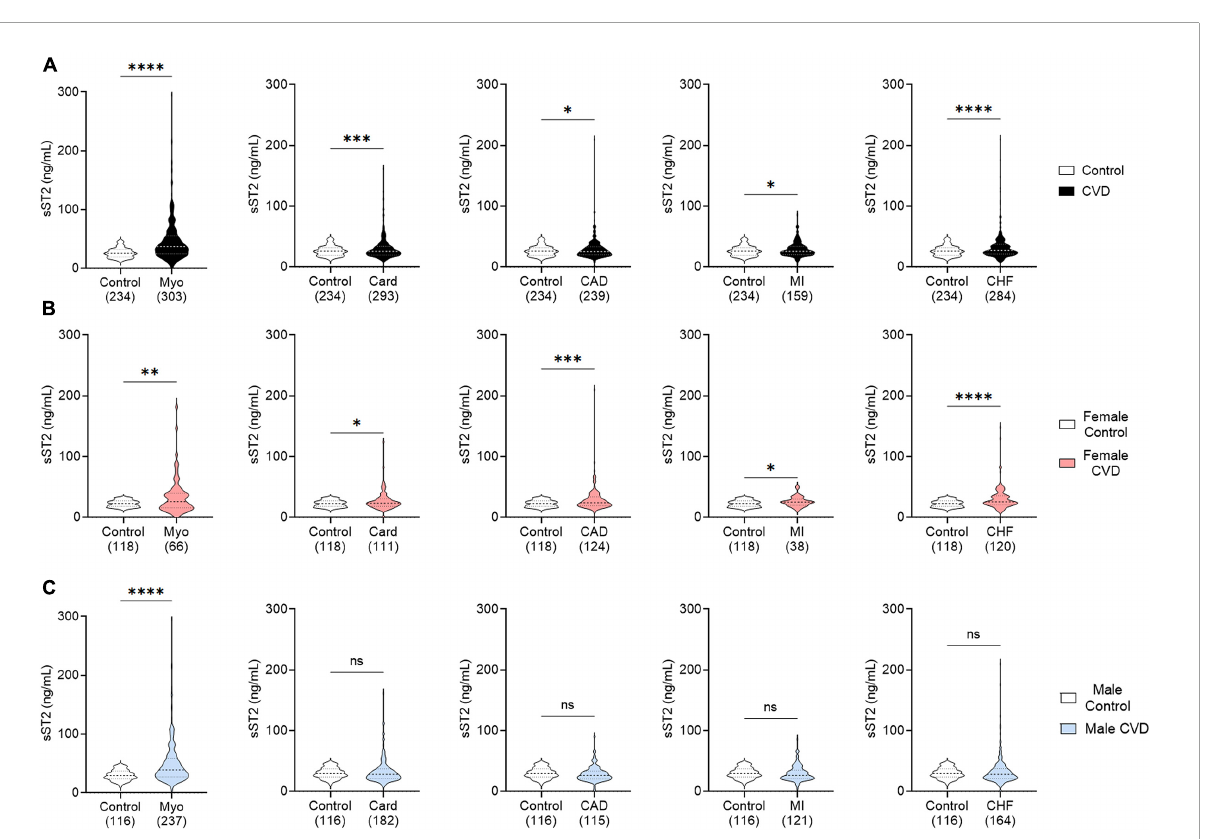
FIGURE1 Serum sST2 increased in CVDs. Serum sST2 levels in (A) men and women (black), (B) women only (peach), or (C) men only (blue) were compared between control patients without known CVDs (white) to those with myocarditis (Myo), cardiomyopathy (Card), coronary artery disease (CAD), myocardial infarct (MI), or congestive heart failure (CHF). Violin plots denote data distribution for each group with p -value calculated using Welch’s t -test: ∗ , p < 0.05; ∗∗ , p < 0.01; ∗∗∗ , p < 0.001; ∗∗∗∗ , p < 0.0001; ns, not